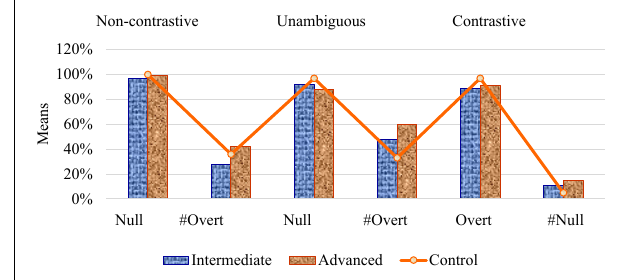
FIGURE 4 | Subject uses in referential contexts.